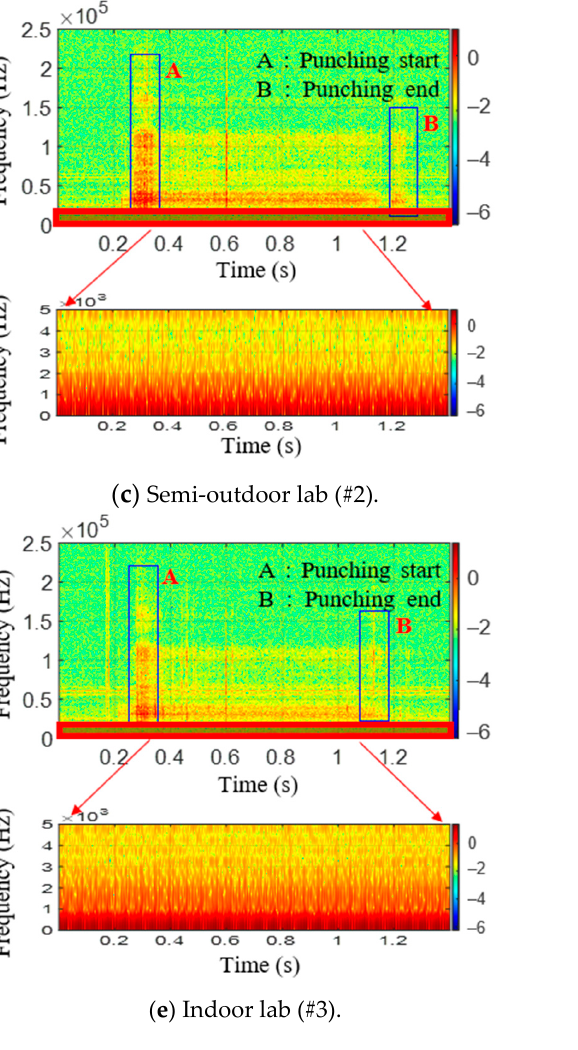
Figure 12. Spectrogram of AE raw data with press process.